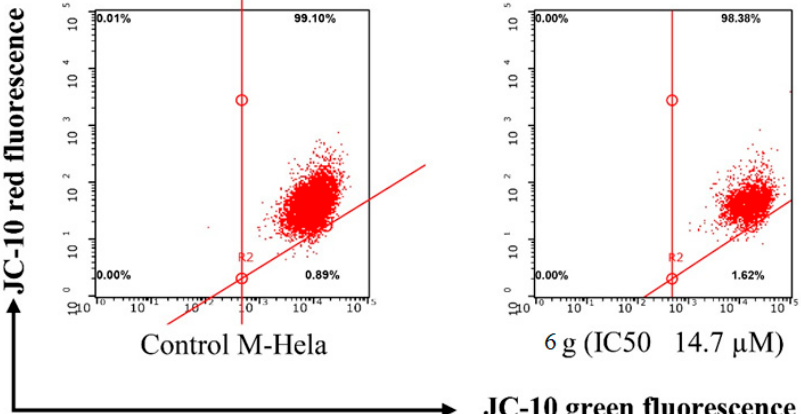
Figure 5. Flow cytometry analysis of M-Hela cells treated with compound 6g , along with the quantification of % of cells with red aggregates. The values are presented as mean ± SD.